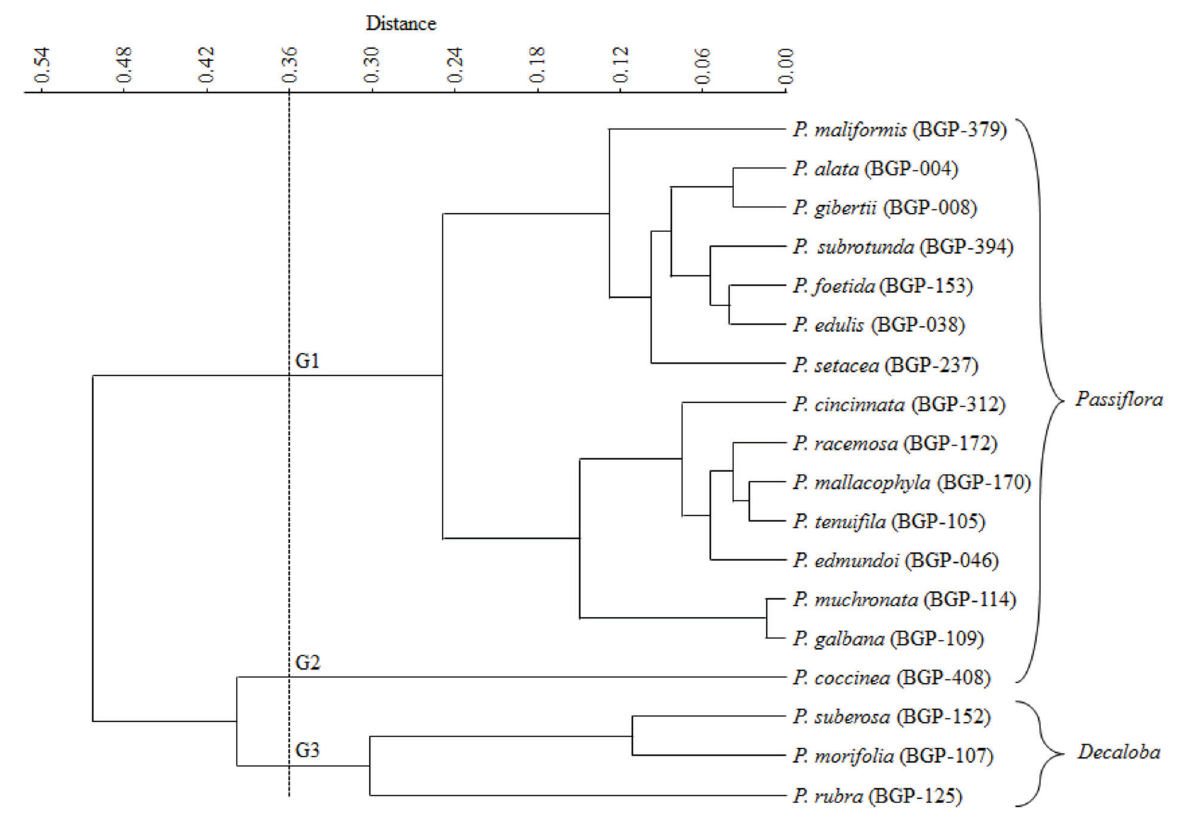
Figure 2 - Dendrogram of the 18 Passiflora species, obtained by UPGMA (unweighted pair group method using arithmetic averages) based on the Gower distance, using the qualitative and quantitative morphopollinic